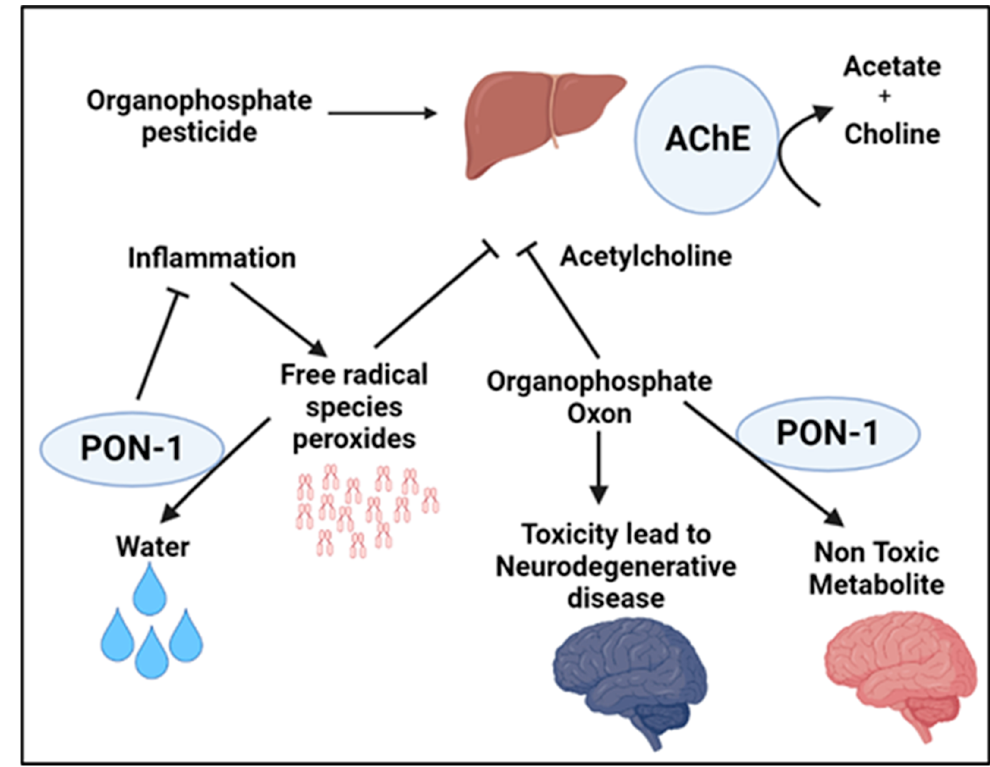
Figure 2. Schematic illustrating the implications of PON-1 enzymatic activity in hydrolyzing com- pounds associated with increased susceptibility to neurodegenerative disease, demonstrating the protective role of PON-1 in the development and progression of Parkinson’s disease.